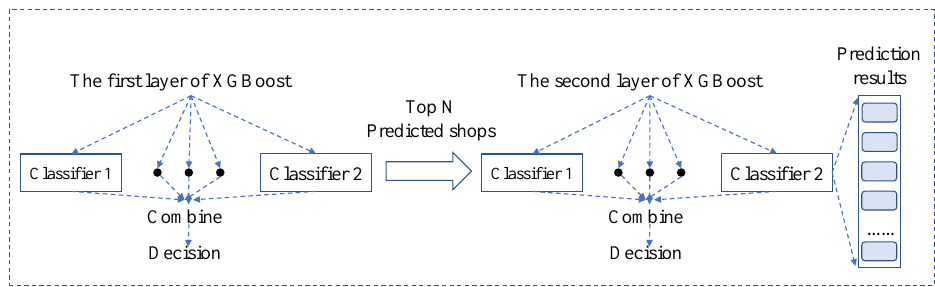
Figure 3. Network architecture of the two-layer XGBoost